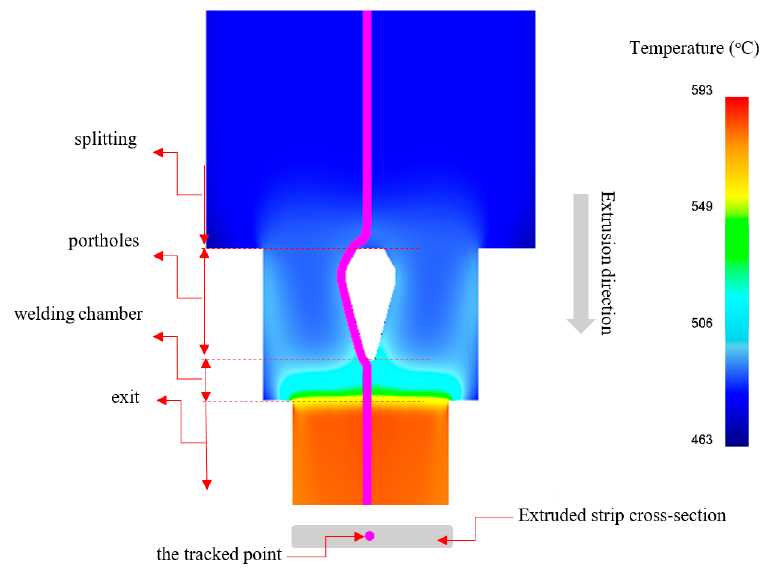
Figure 5. Schematic showing a cross-sectional view of the porthole die extrusion process indicating the flow path of the weld seam material at different stages in the process.